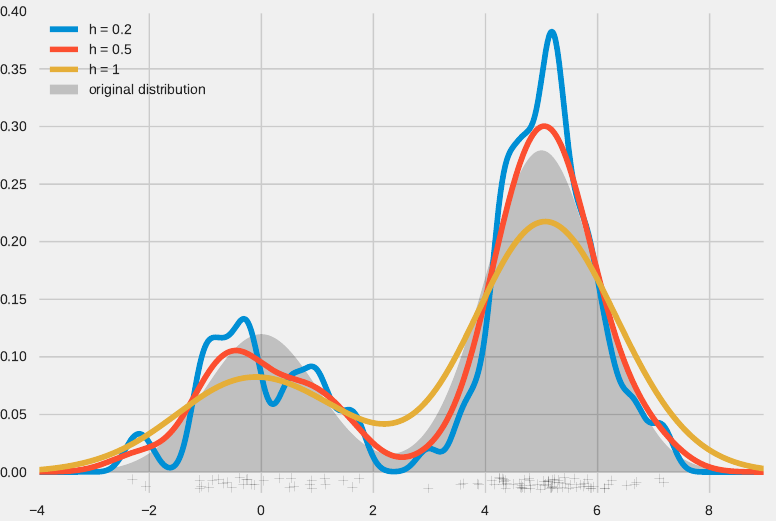
Figure 1. The grey curve represents the original (underlying) distribution of the data. The colored curves represent the KDE estimations of the original curve for different values of h